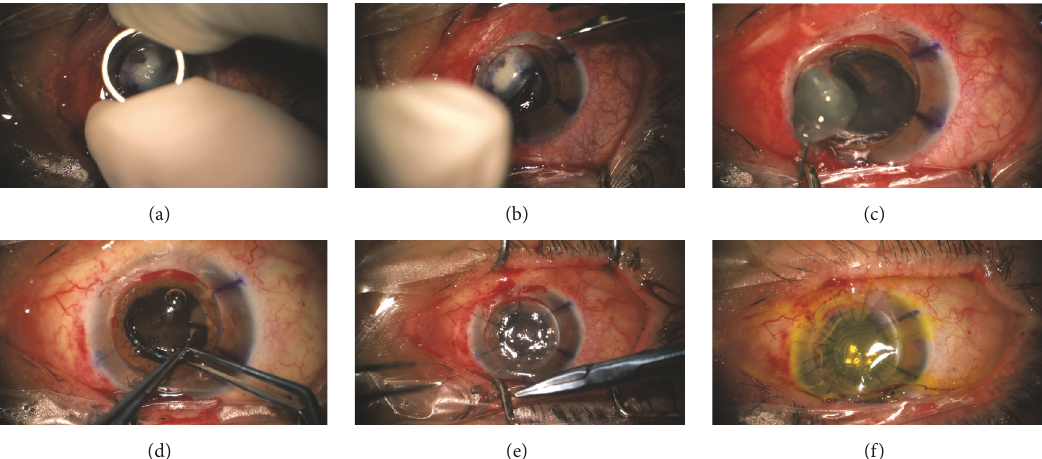
Figure 2: Simultaneous noncentered photoactivated chromophore for keratitis-corneal collagen cross-linking (PACK-CXL) and penetrating keratoplasty. (a) Corneal trephination. (b) Cornea removal. (c) Open-sky cataract removal. (d) Intraocular lens implantation. (e) Donor cornea suturing. (f) Riboflavin impregnation.